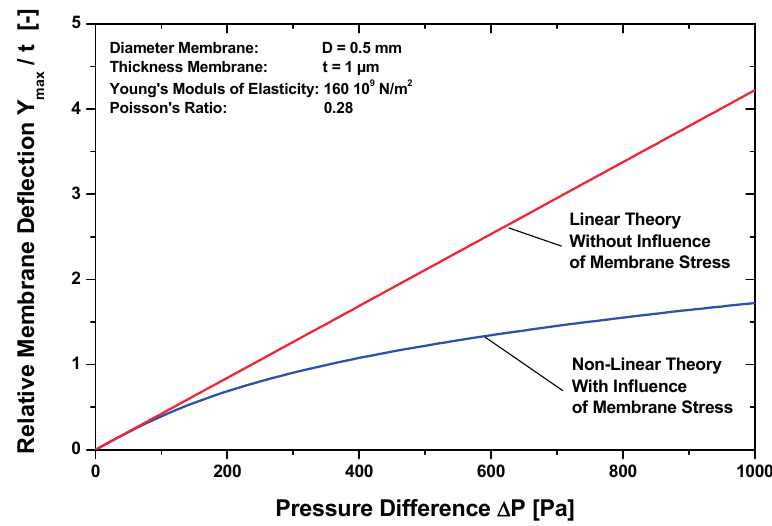
Figure 13. Relative plate deflection at r = 0 as a function of applied pressure difference compared the influence of a membrane stress for a water-filled